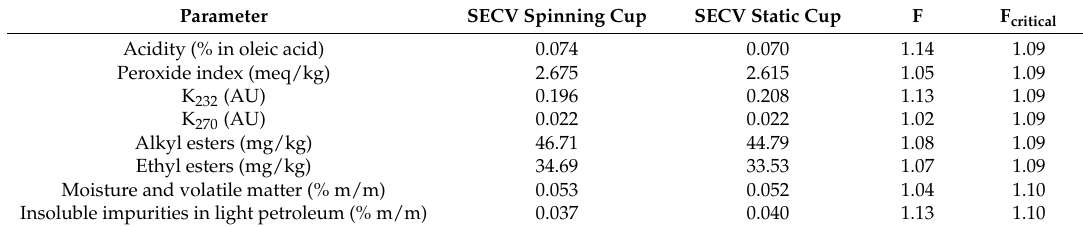
Table 2. Comparison between SECV values obtained for the best models for predicting olive oil quality parameters using the FNS-6500 SY-I monochromator with spinning sample presentation and the FNS-6500 SY-II monochromator with static sample presentation; Fisher test ( p ≤ 0.05).